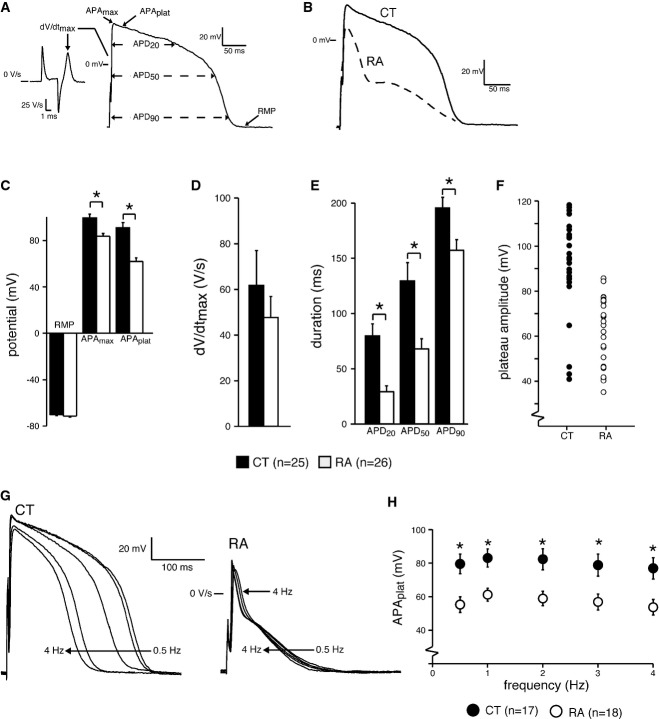
AP characterization of CMs generated from control and RA-treated differentiations
A AP illustrating the analyzed parameters.

B Representative APs of day 31 CMs from control (CT) and RA-treated (RA) groups at 1 Hz.

C–E RMP, APAmax and APAplat (C), dV/dtmax (D) and APD20, APD50 and APD90 of CT and RA CMs (E).

F Plot showing all measured APAplat values of CT and RA CMs.

G Representative APs of CT and RA CMs at 0.5–4 Hz.

H Average APAplat at 0.5–4 Hz. Please note that the AP differences in morphology are present at all measured frequencies.

Data information: Data are presented as mean ± SEM. *P < 0.05 by unpaired t-test or Mann–Whitney rank-sum test for (C–E). In (C), P = 0.238 for RMP; P < 0.001 for APAmax and APAplat. In (D), P = 0.598 for dV/dtmax. In (E), P ≤ 0.001 for APD20; P = 0.009 for APD50;
P = 0.04 for APD90. Two-way repeated measures ANOVA followed by pairwise comparison using the Student–Newman–Keuls test for (H). *P = 0.002, 0.006, 0.003, 0.004 and 0.003, respectively, for comparison of APAplat between CT and RA groups at frequencies of 0.5, 1.0, 2.0, 3.0 and 4.0 Hz. AP = action potential; APAmax = maximum AP amplitude; APAplat = AP plateau amplitude; APD20, APD50 and APD90 = AP duration at 20, 50, and 90% repolarization, respectively; CMs = cardiomyocytes; dV/dtmax = maximum upstroke velocity; RMP = resting membrane potential.